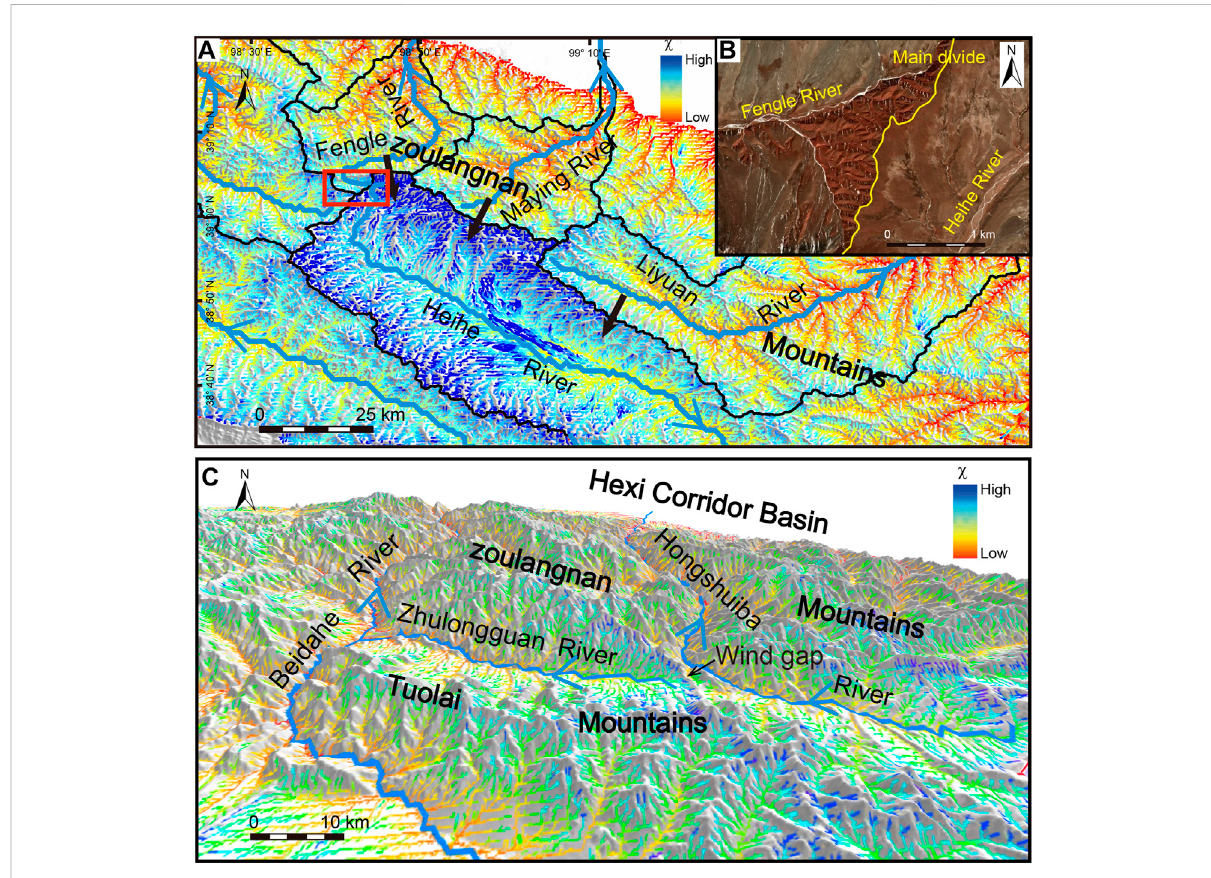
FIGURE 6 (A) : χ -map of the upper Heihe River and its surrounding areas, the red box shows the location in Figure 6B. Black arrows indicate the predicted divide migration directions. (B) : Google Earth image of the Fengle River and Heihe River. (C) : Geomorphic features and χ -map of the Zhulongguan River and Hongshuiba